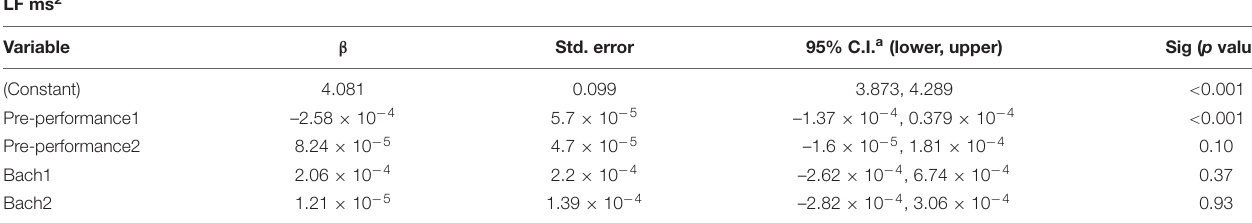
TABLE 7 | Independent association of LF ms 2 with flow during the Bach performance. LF ms